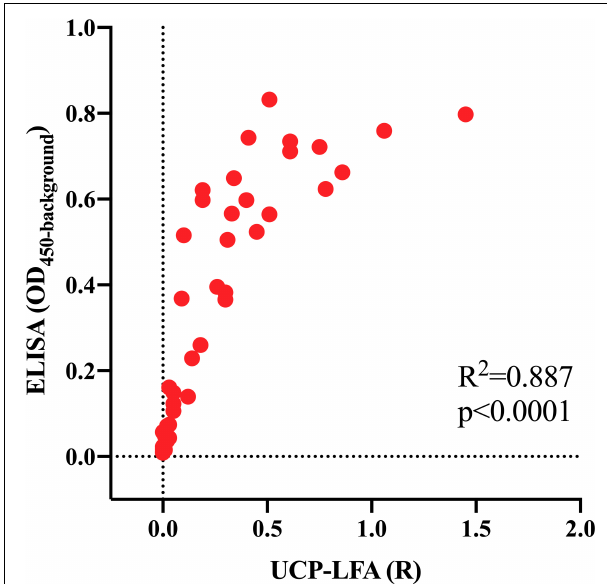
FIGURE 3 | Correlation of anti-PGL-I IgM levels in M. leprae infected armadillos in UCP-LFA and ELISA. Serum samples ( n = 41) of M. leprae [1 × 10 9 bacilli; NHDP 63 ( n = 9), NHDP 98 ( n = 4), or Brazil 4923 ( n = 4)] infected armadillos at multiple time points, were assessed for anti-PGL-I IgM by UCP-LFA, and for anti-PGL-I IgM by ELISA. UCP-LFA results are displayed as the Ratio value (R) between Test (T) and Flow-Control (FC) signal ( x -axis); ELISA results are displayed as optical density at 450 nm corrected by background (OD 450 - background ; y -axis). R 2 is the square of the Spearman correlation coefficient.